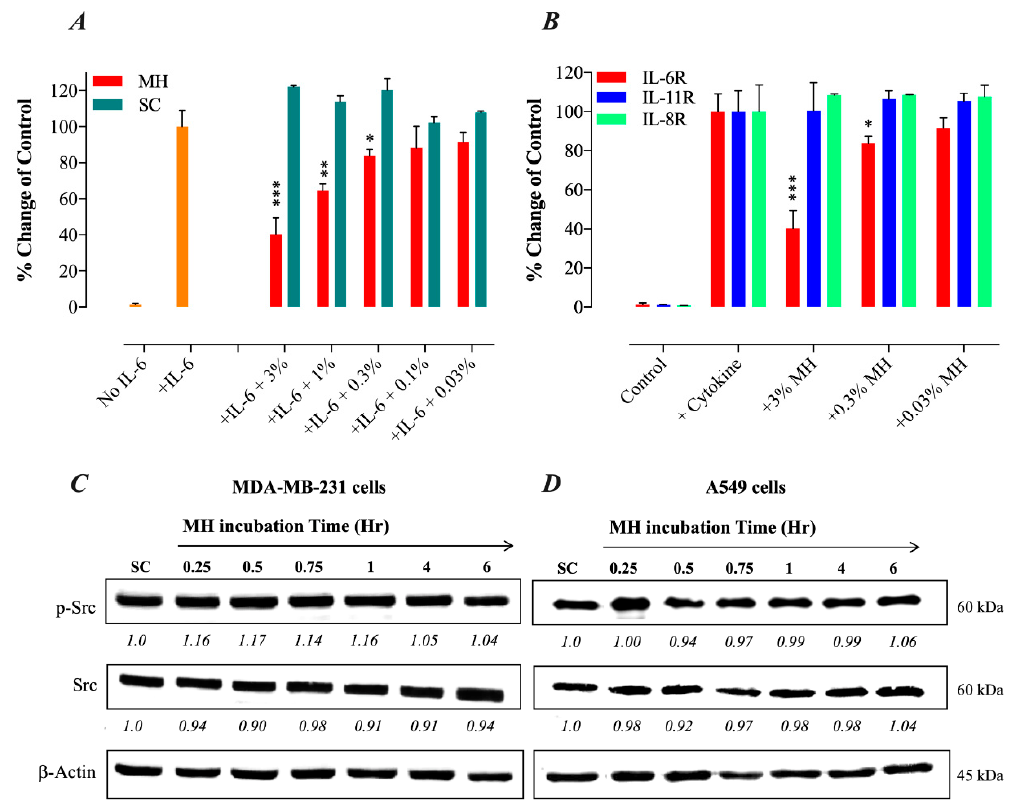
Figure 3. MH inhibits IL-6 / STAT3 signaling pathway by selective blockade of IL-6R α . ( A ) ELISA-based binding assay was performed to test for a possible direct association between MH and IL-6R α and its consequences on IL-6 binding to its receptor. For the competition assay, various concentrations of MH (0.03–3%) or sugar control solution (SC) were tested for the ability to inhibit the binding of IL-6 protein to immobilized sIL-6R α competitively. ( B ) A comparison of the ability of MH to bind di ff erent cytokine receptors (IL-6R α , IL-8R, and IL-11R α ). Pre-incubation of various concentrations of MH (3%, 0.3%, and 0.03%) with either recombinant IL-11R α or IL-8R proteins failed to a ff ect the binding of their respective cytokines. The data depict the % change in the binding of the ligands to their respective receptors in the presence of MH. The data are expressed as means ± SD of 4–6 replicates per group and are pooled from two independent experiments. Asterisks denote statistically significant di ff erences in MH-treated samples compared to control wells (* p < 0.05; ** p < 0.01; *** p < 0.001), as determined by the unpaired, two-tailed Student’s t-test. ( C , D ) MH does not alter tyrosine-phosphorylated Src (p-Src) or total Src kinase levels. ( C ) MDA-MB-231 cells were treated with 1% MH for the indicated time points ( C ) and analyzed by Western blotting for the relative protein expression of p-Src, total Src, or β -actin, as control. ( D ) A549 cells were similarly exposed to 1% MH for the indicated times and analyzed for p-Src and total Src expression. The numbers below each blot indicate changes in band intensity compared to control, as determined by densitometric analysis. The data are representative of three independent experiments.